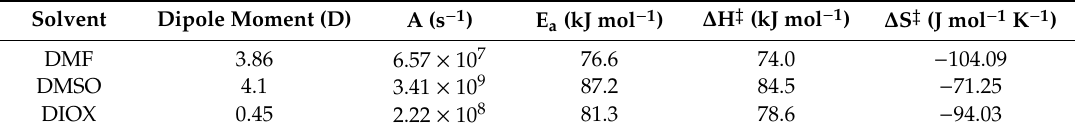
Table 7. AZO2 thermodynamic activation parameters.